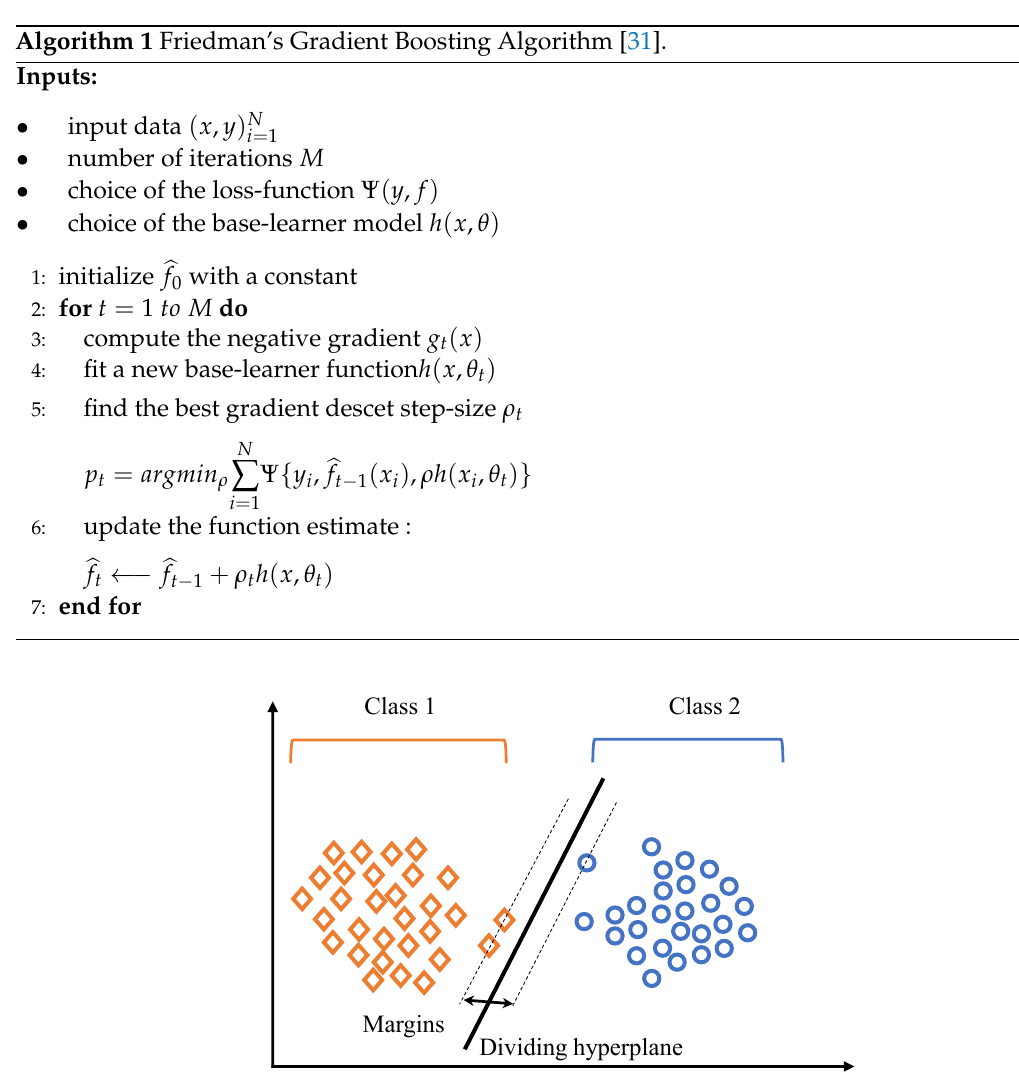
Figure 2. The architecture of the support vector machines. The dashed lines on the figure shows the best dividing margins while the thick black line represent the dividing hyperplane as drawn by a support vector machine